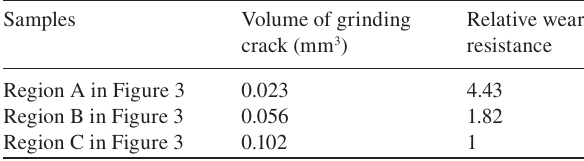
Table 1 The wear test results of the FGM